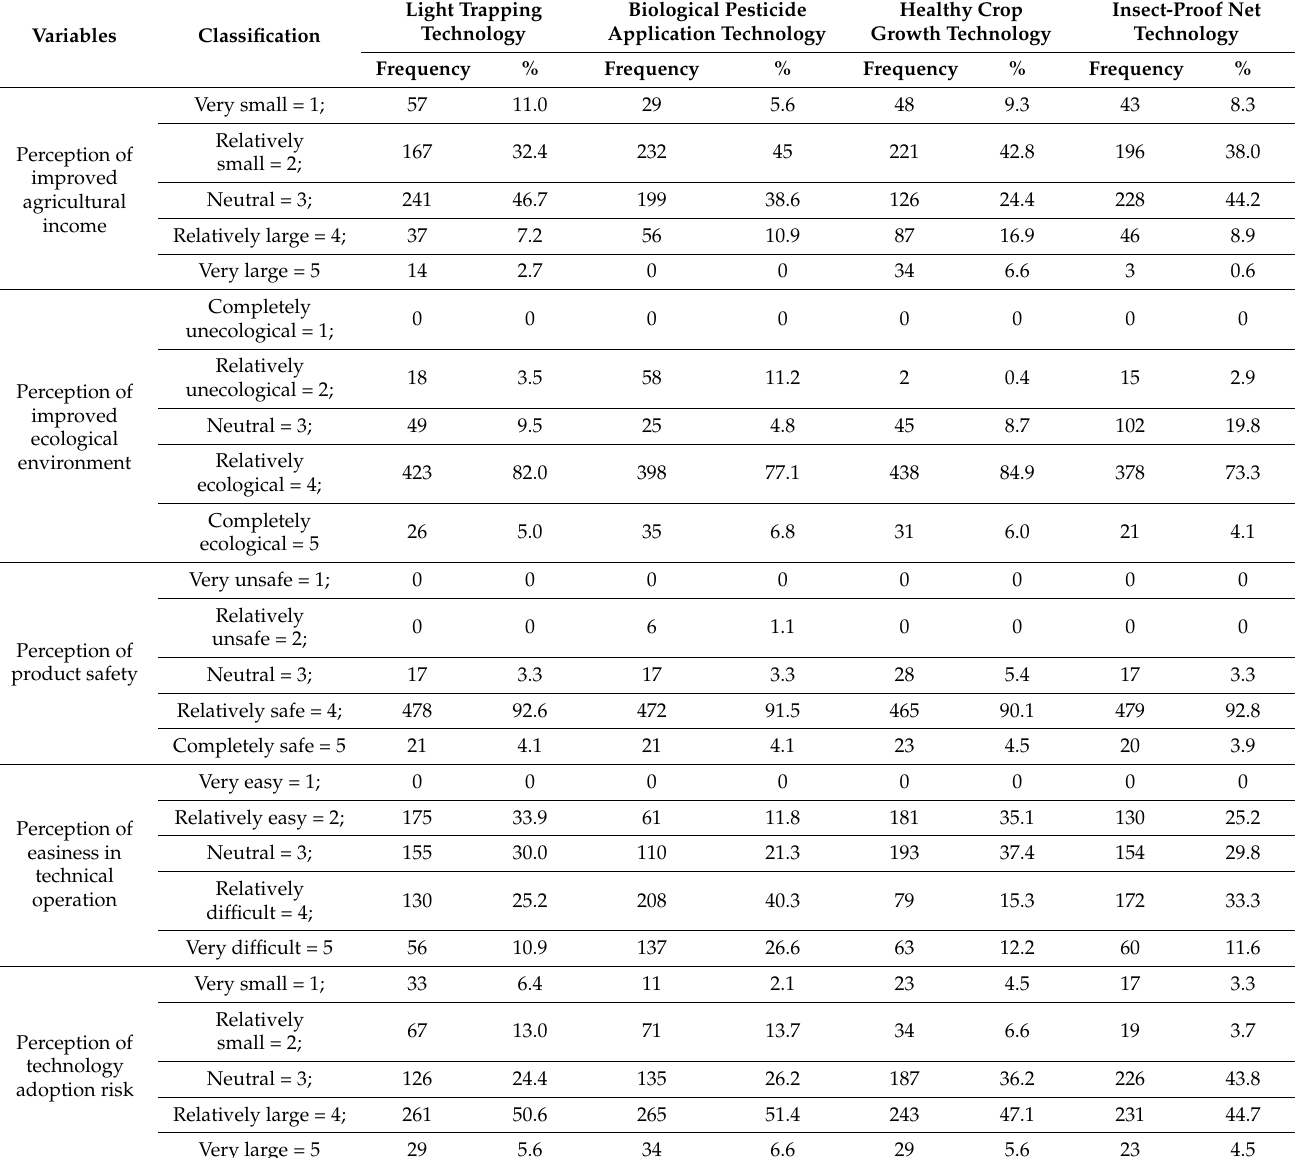
Table 3. Farmers’ psychological perceptions of pesticide reduction